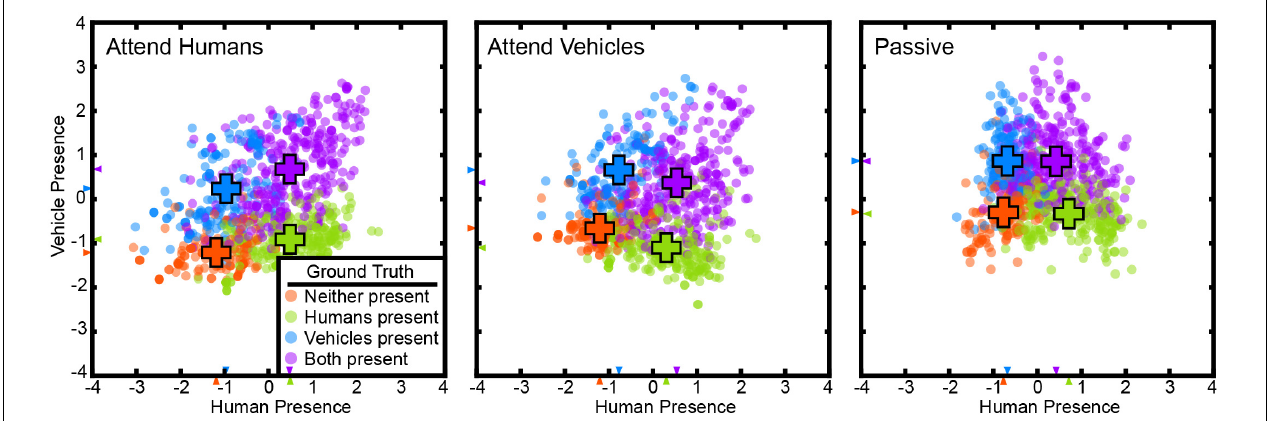
FIGURE 1 | The state space method recovered a task-related state space in the visual attention task. Cortical activity at each TR for subject S2 is projected to a point in this space. The state space is projected on to the 2D plane spanned by the “human presence” (horizontal) and “vehicle presence” (vertical) axes. Projections are shown for the attend-human, attend-vehicles, and passive viewing conditions. Positive values indicate presence, and negative values indicate absence. TRs are color-coded by their ground truth states. Orange: neither present; blue: only humans present; green: only vehicles present; purple: both humans and vehicles present. Crosses indicate the mean positions of each group. The cluster separation index (CSI) is 0.75 for attend-humans, 0.69 for attend-vehicles, and 0.67 for passive ( p < 1e-5, permutation test), all indicating significant separation of the clusters. Clusters are more distinct in the attentive conditions than in the passive condition ( p < 1e-5, permutation test). These results are consistent with the hypothesis that task variables are represented in a low-dimensional task-related subspace of the cortical activity space, and that attention increases the separation of the states in this task-related state space.